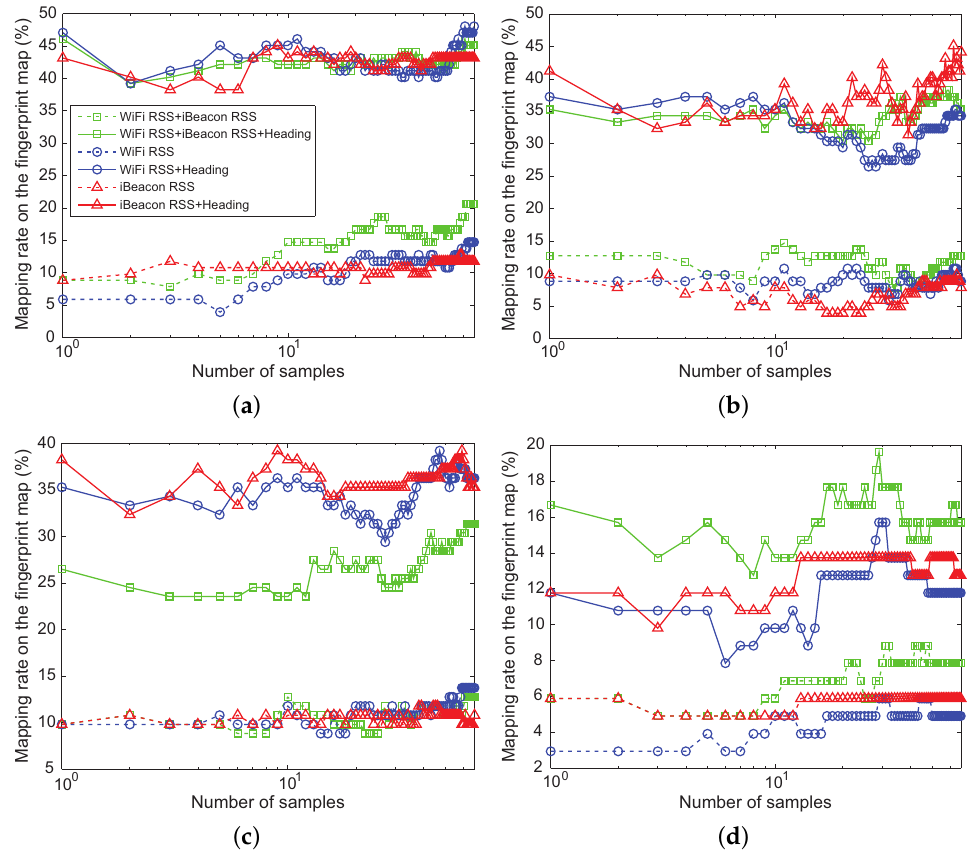
Figure 10. Mapping rate of: ( a ) NBC; ( b ) KNN; ( c ) ANN; and ( d ) SVM in Scenario S2 with poor wireless signal